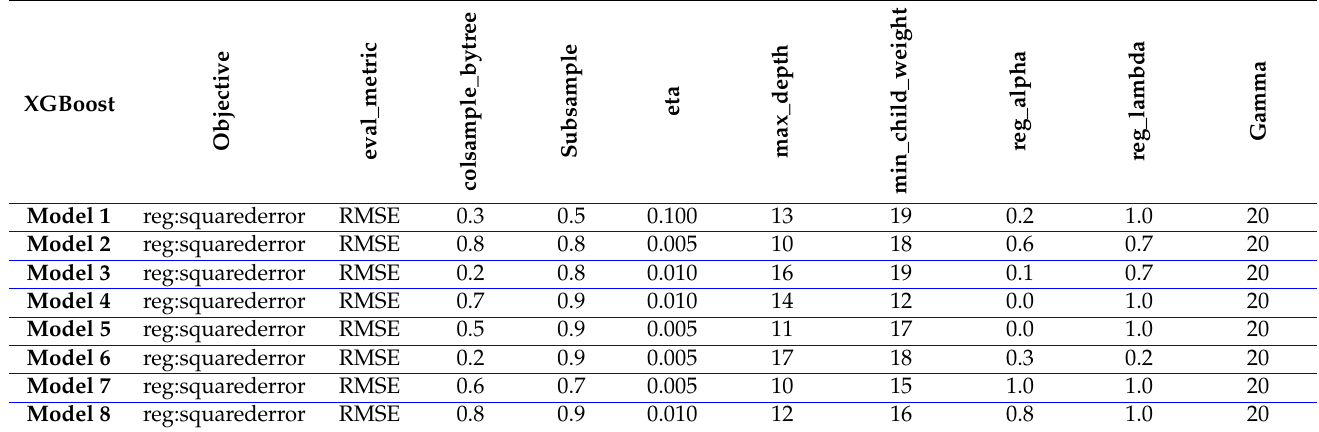
Table A2. Optimal hyperparameters for the XGBoost models (d-serie laser module).